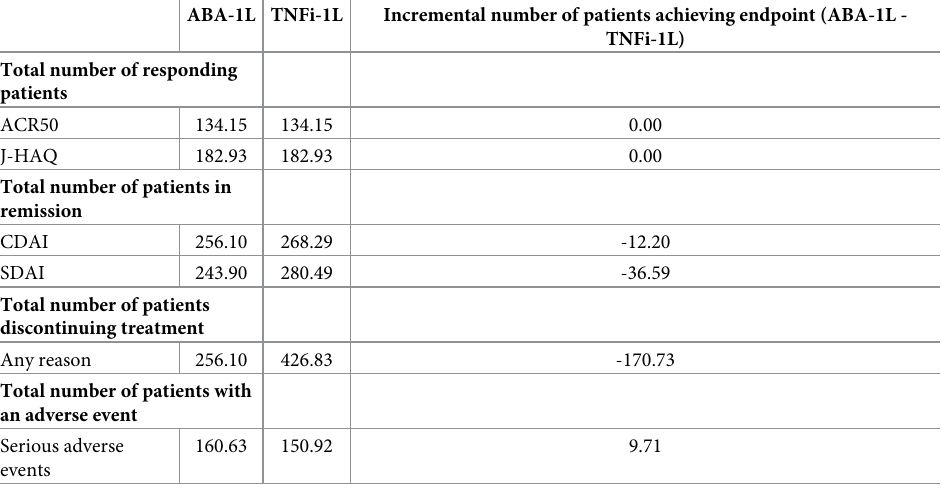
Table 3. Health outcomes per cohort for the overall AMPLE population after 2 years (ABA-1L vs. TNFi-1L).